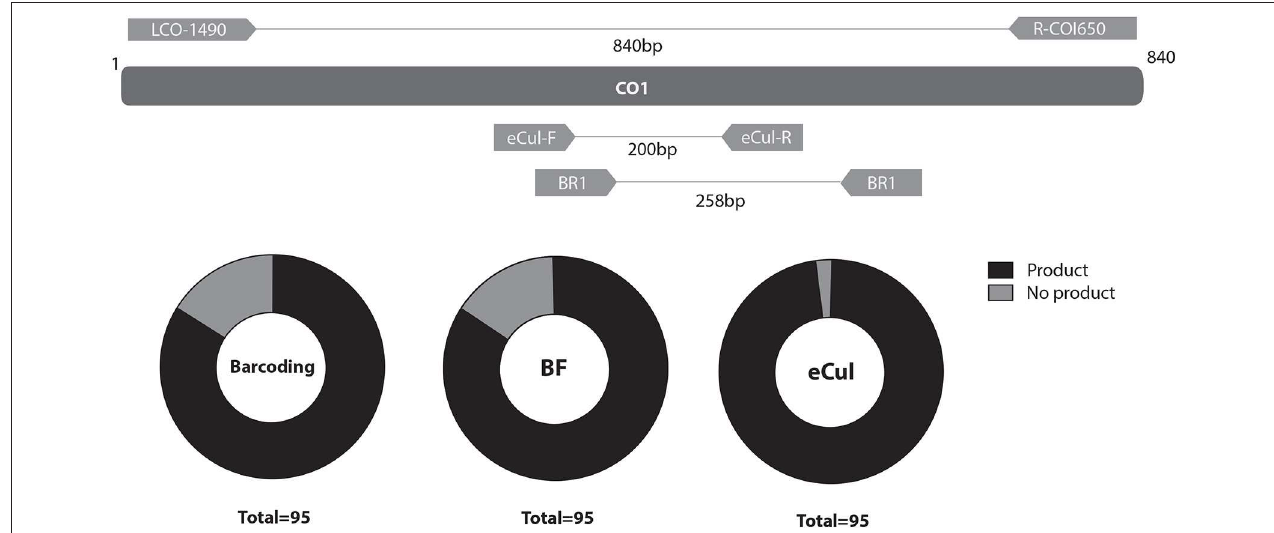
FIGURE 2 | Topography and PCR-efficacy of LCO-1490/R-COI650, BF1/BR1 (BF) and eCul-F/eCul-R (eCul). Primer pairs BF and eCul are shown with their respective position on the CO1-region, as amplified by the LCO-1490/R-COI650 primers. Note that the BF and eCul primers span an overlapping region, highlighting that this is a highly informative region. The black part of the pie chart shows the PCR-efficacy (e.g., the ability of the PCR protocol to generate a PCR fragment), indicating that the primer is able to pick-up the specimen and corresponding species or species complexes. Courtesy of Erik-Jan Bosch.